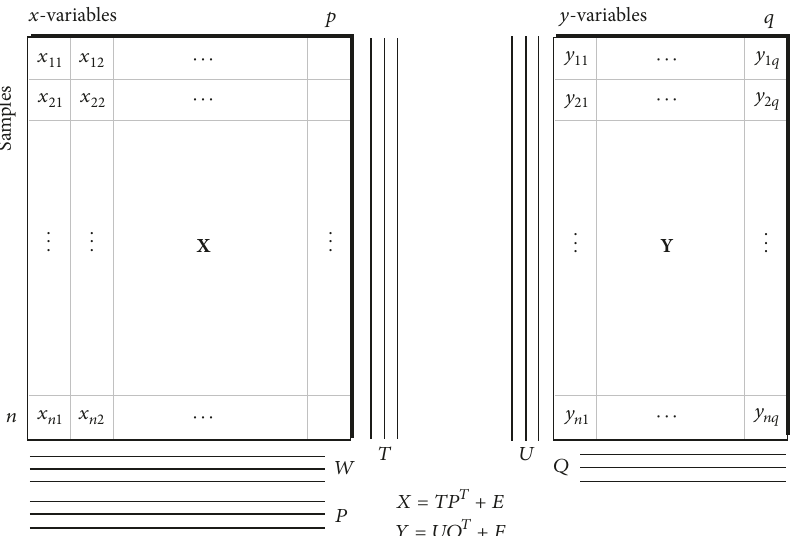
Figure 1: 𝑋 - 𝑌 data and models in the PLS-R modeling approach [15]. The parameters that emanate from PLS-R calibration include 𝑃 ( 𝑋 loadings); 𝑊 ( 𝑋 loading weights); 𝑇 ( 𝑋 scores); 𝑈 ( 𝑌 scores); and 𝑄 ( 𝑌 loadings). 𝐸 and 𝐹 are the residuals for 𝑋 and 𝑌 , respectively.